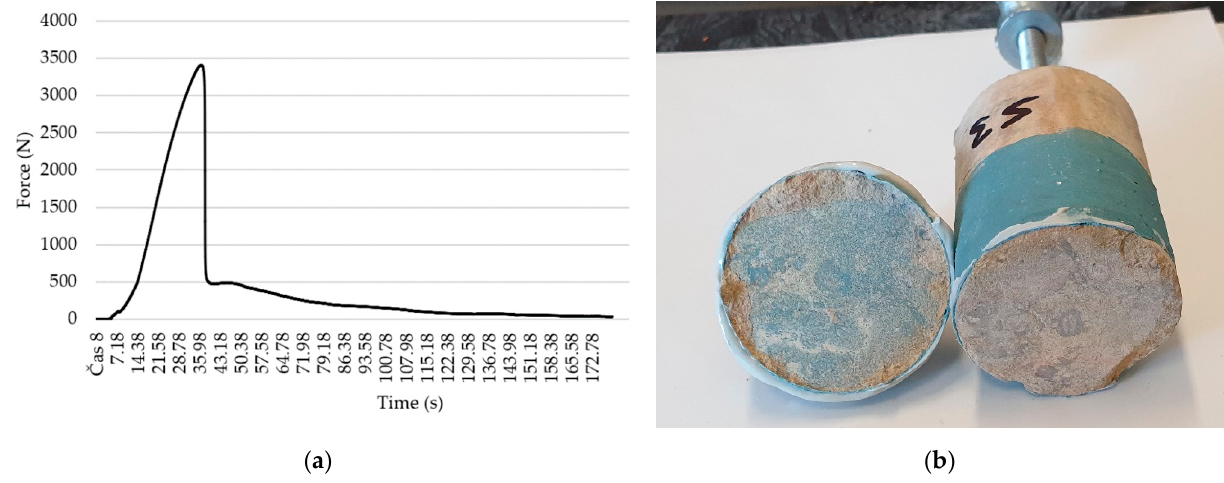
Figure 13. ( a ) Typical course of tensile force on a test specimen; ( b ) adhesive failure.